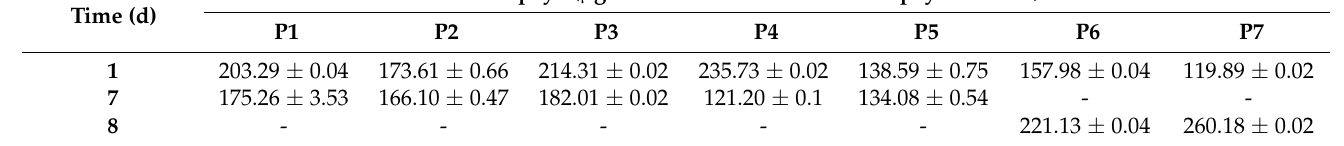
Table 3. Changes in total phenolic content (TPC) of the fermented papaya samples during fermenta- tion assays (P1 to